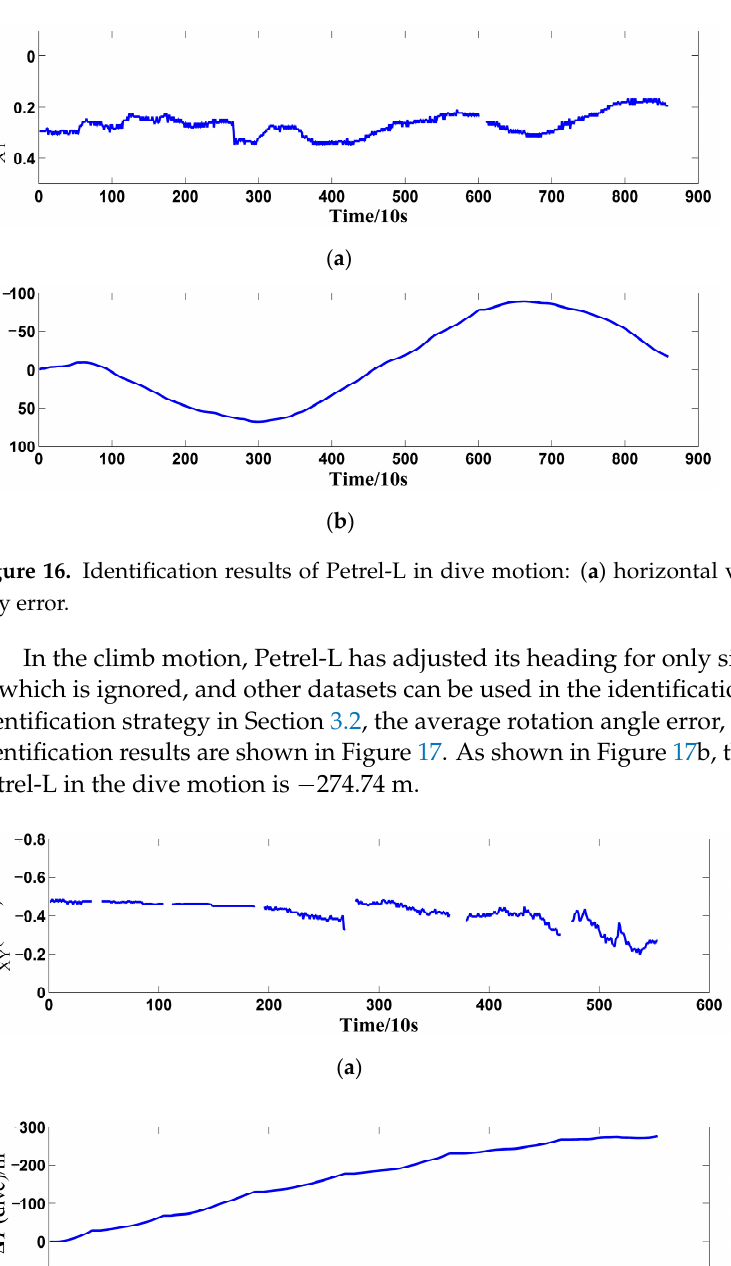
Figure 15. Datasets of Petrel-L in climb motion: ( a ) vertical velocity, ( b ) pitch angle, ( c ) heading.